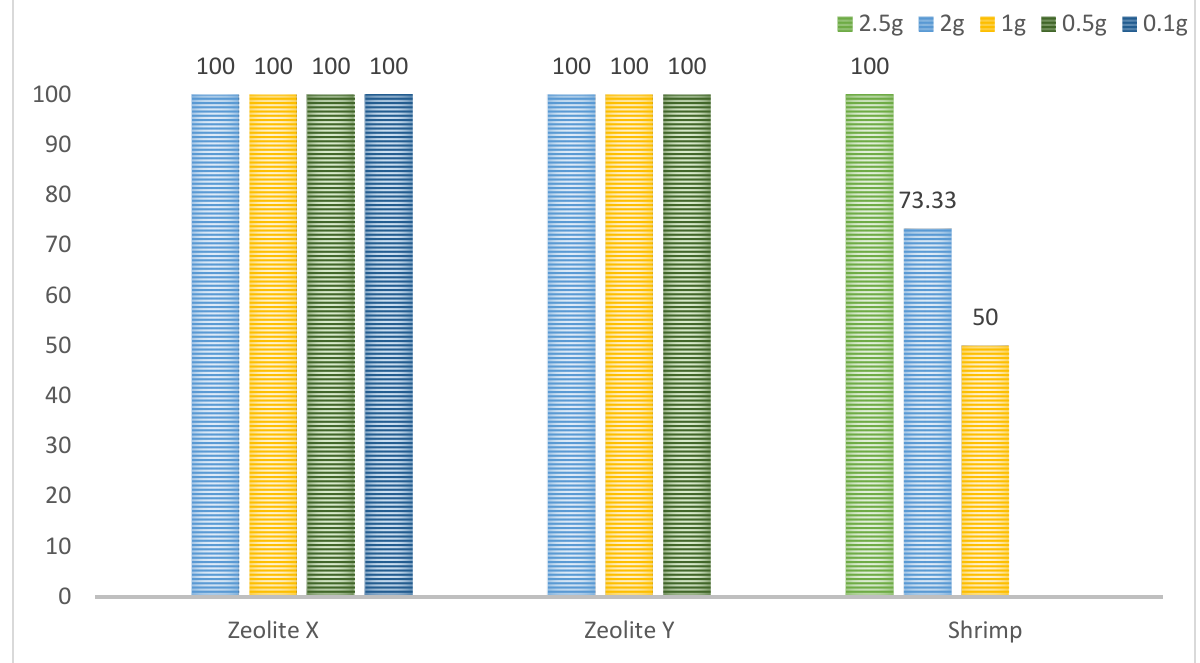
Figure 5. Percentage representation of Cryptosporidium -positive samples based on the type of filter .